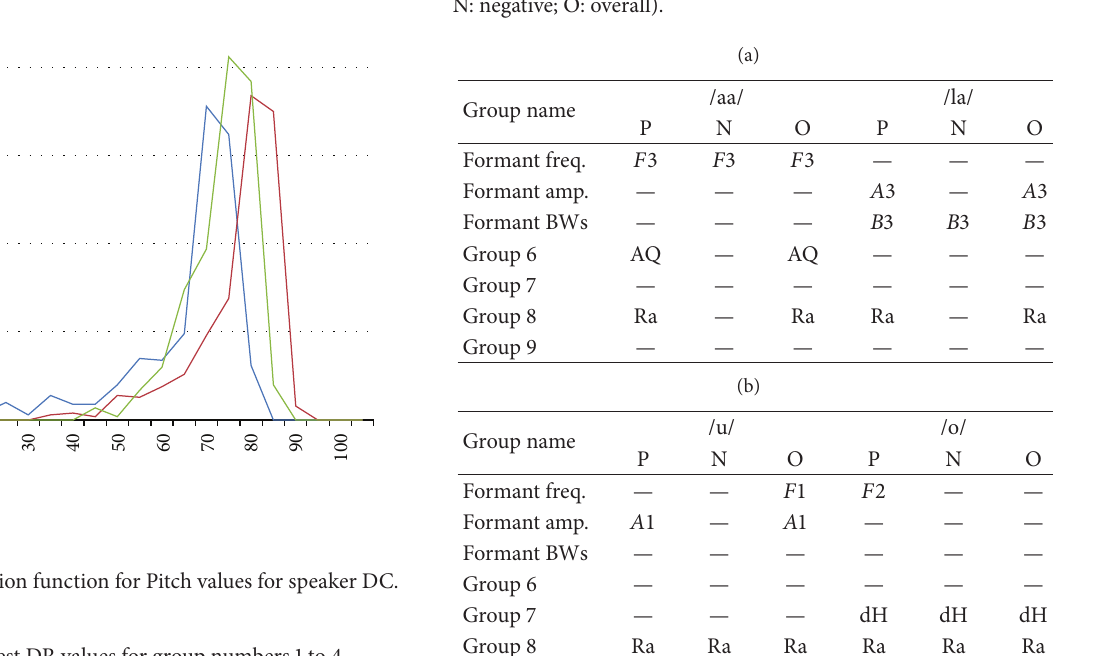
Table 9: Highest DR values for group numbers 5 To 9. (P: positive; N: negative; O: